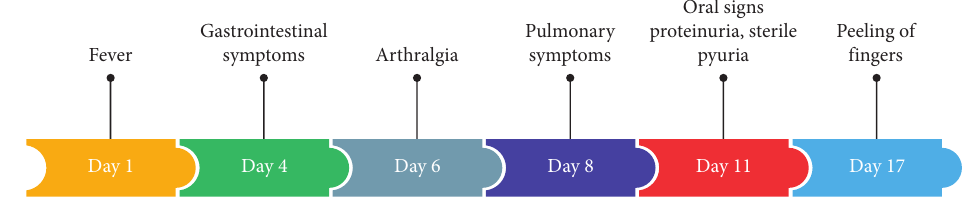
Figure 2: The timeline of the clinical